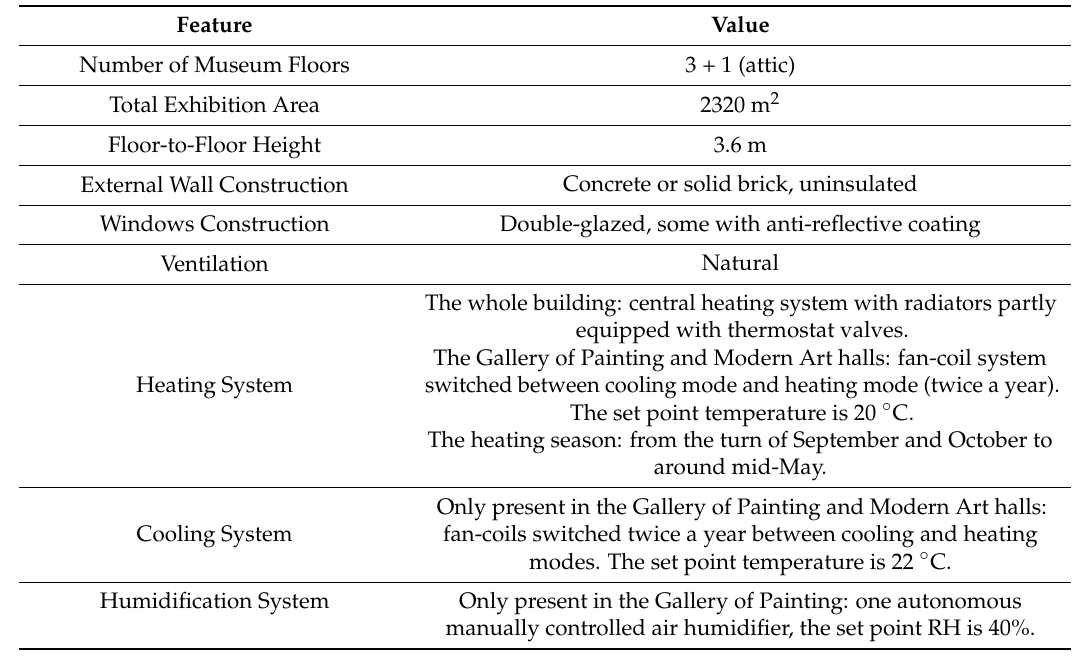
Table 2. Characteristics of the museum